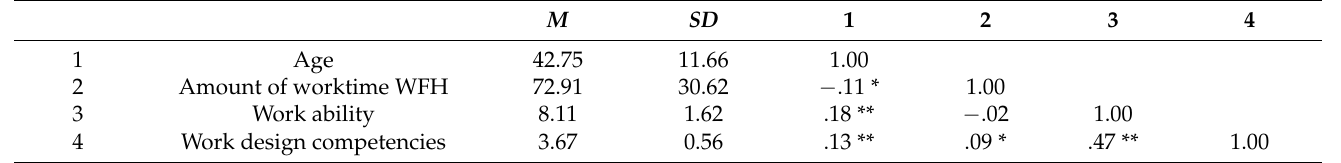
Table 5. Descriptive statistics and bivariate correlations of test variables ( N =